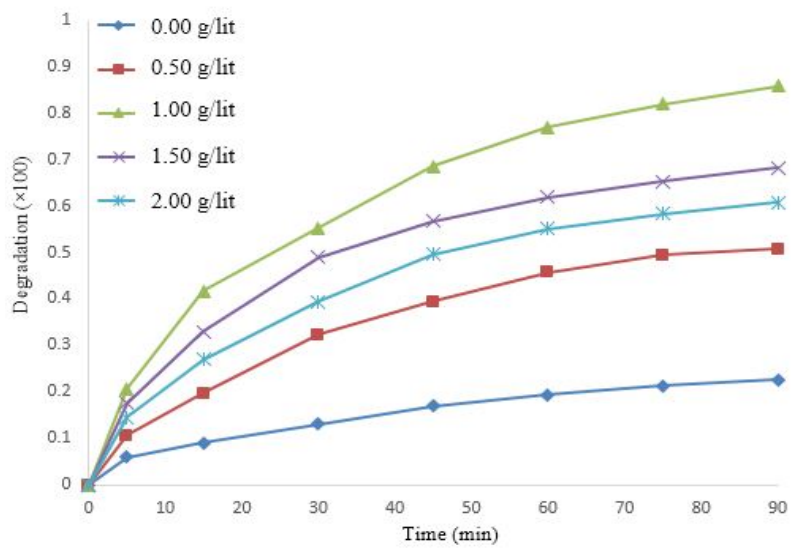
Fig. 11. Effect of Initial Catalyst Concentration on Catalytic Degradation of Phenol